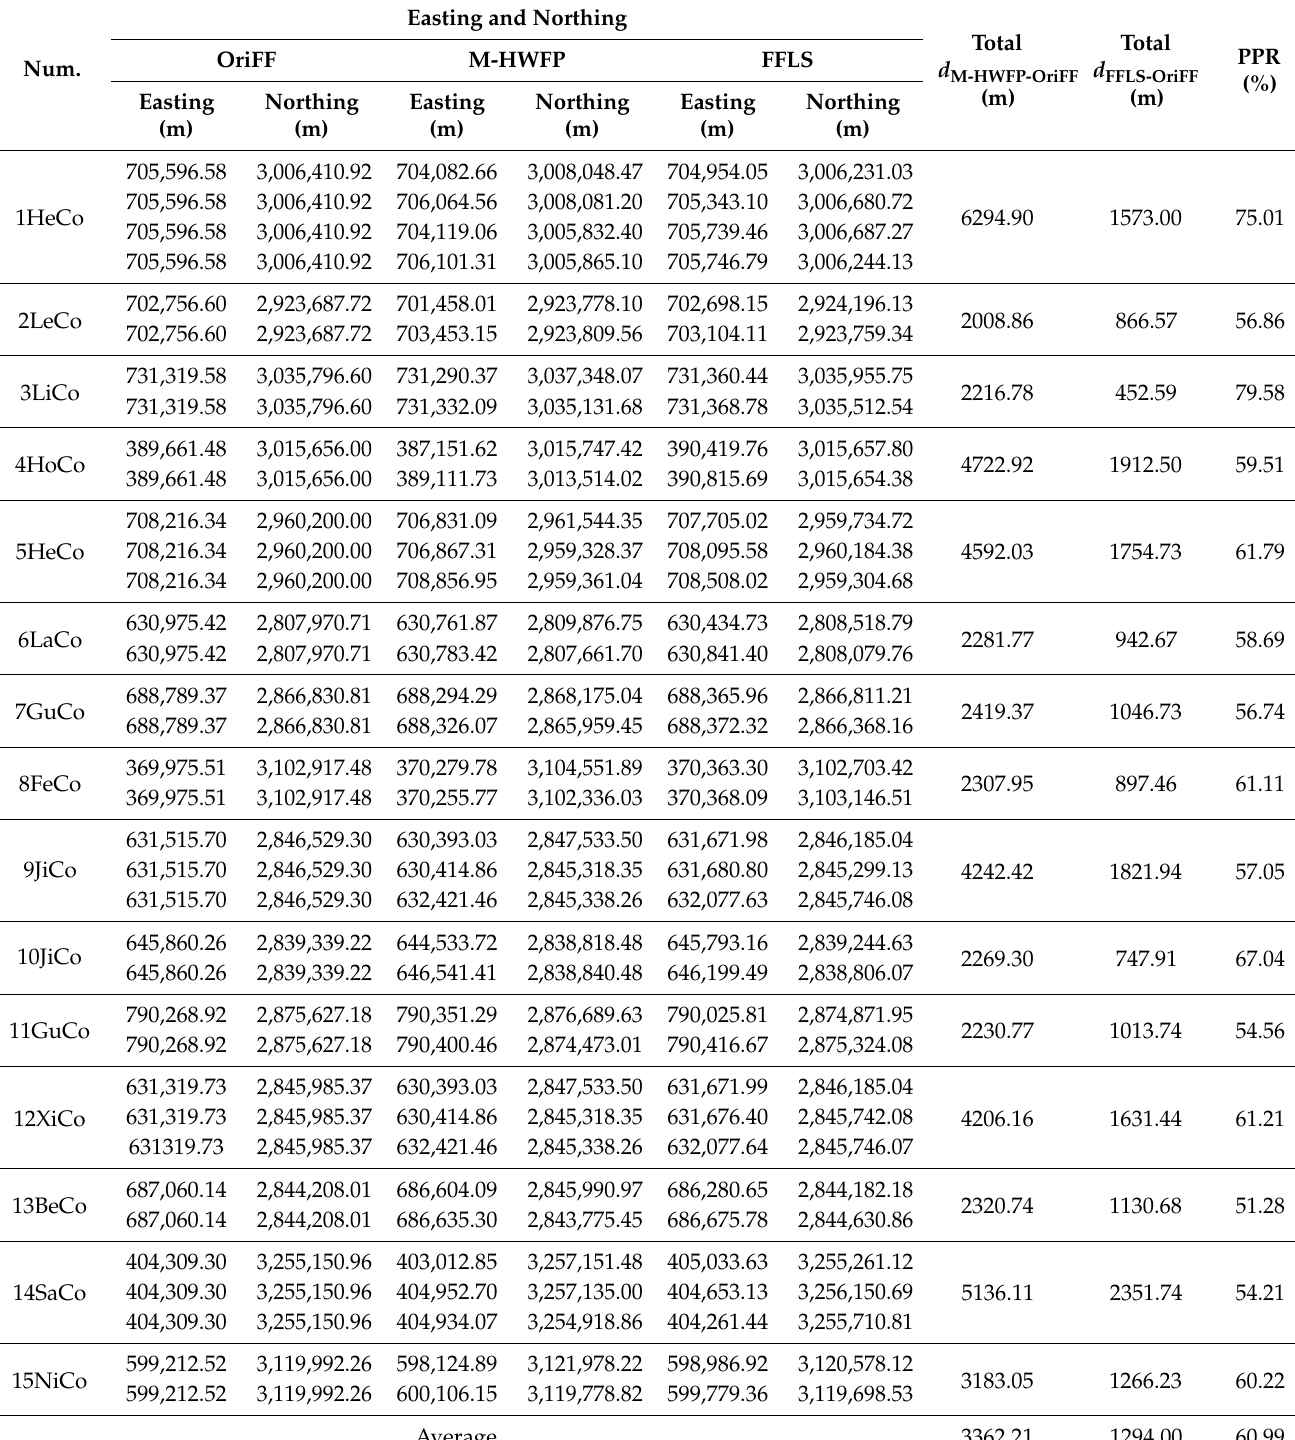
Table 2. Positioning-accuracy comparison of M-HWFP to OriFF and FFLS to OriFF. PPR represents positioning-precision